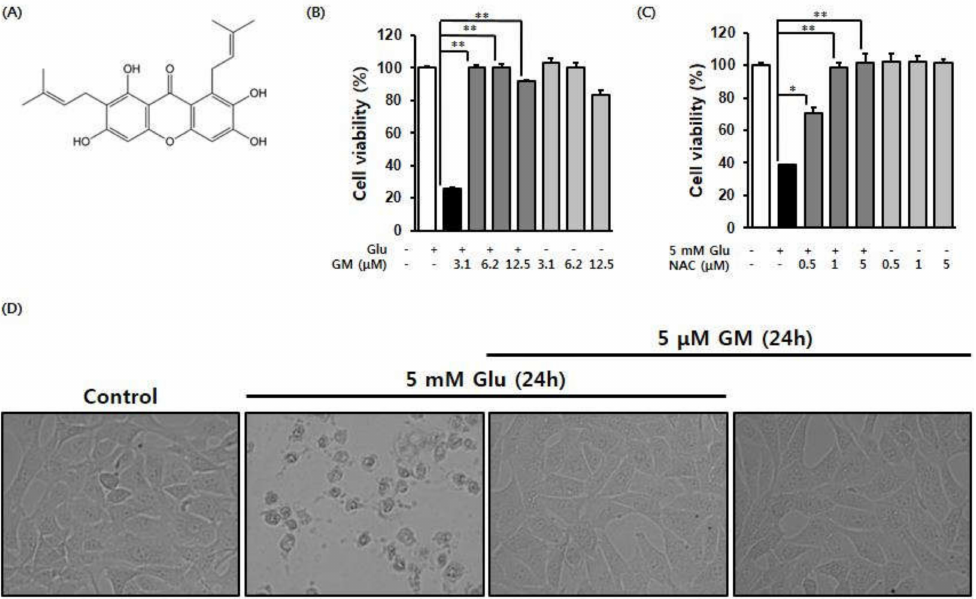
Figure 1. Protective effect of γ -mangostin (GM) and N-acetyl cysteine against (NAC) on glutamate-induced cell death in HT22 cells. ( A ) Chemical structure of GM isolated from mangosteen. ( B ) Effect of GM on glutamate-induced cell death in HT22 cells (mean ± S.E.M. * p < 0.05 ** p < 0.01 versus glutamate-treated HT22 cells). ( C ) Effect of NAC on glutamate- induced cell death in HT22 cells. Bars represent the percentage of viable cells. Data are expressed as the mean ± standard deviation (SD). ** p < 0.01 versus the Glu-treated cells. ( D ) After exposure to 5 mM Glu with/without GM for 24 h; cell images were obtained using a microscope (20 ×